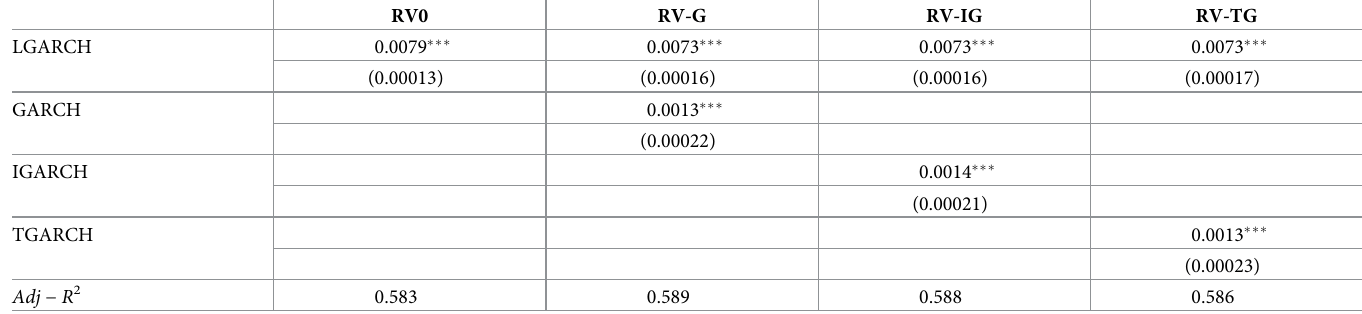
Table 8. Regression results for realized variance (in-sample). This table reports the Mincer-Zarnowitz regression result for the model performance comparison regard- ing the in-sample realized variance. RV0 represents the single variable regression for our model only, RV-G represents the model 1 is our model and model 2 is GARCH model defined in Eq (13); RV-IG represents the model 1 is our model and model 2 is IGARCH model defined in Eq (13); RV-TG represents the model 1 is our model and model 2 is TGARCH model defined in Eq (13). � , �� , ��� indicate statistical significance at 10%, 5% and 1% levels, respectively.